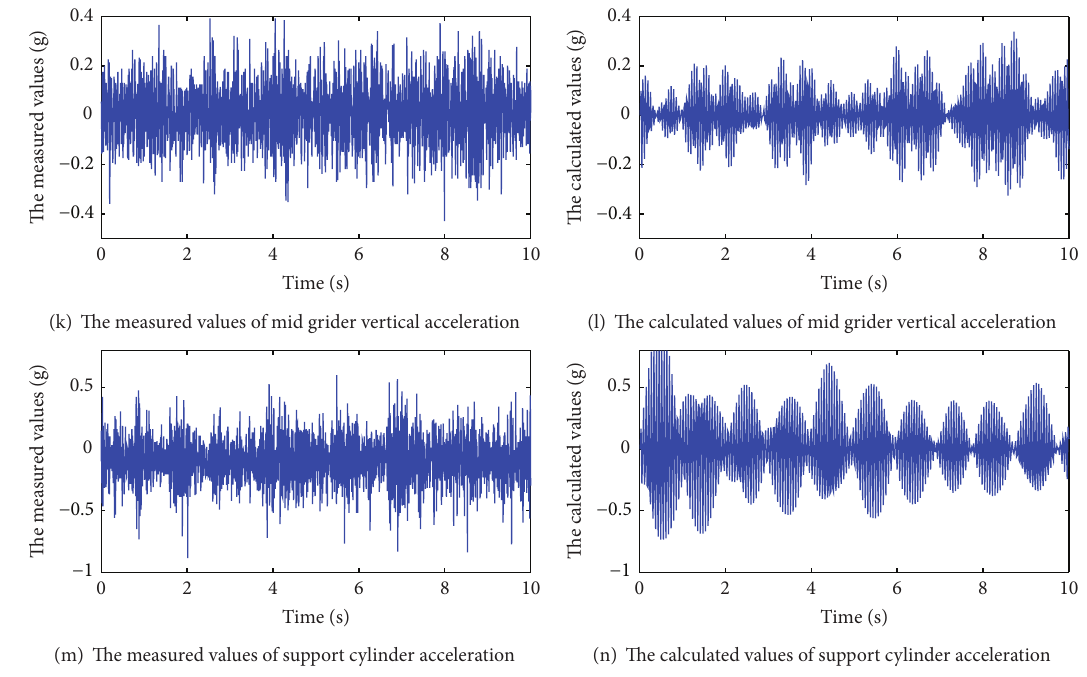
Figure 9: The measured values and calculated values of each component. Table 2: The rain flow count statistics for each test point. The measured values The calculated values Error The mean of MSE of the The mean of MSE of the The mean of MSE of the amplitude amplitude amplitude amplitude amplitude amplitude 0.1323 0.1277 0.1610